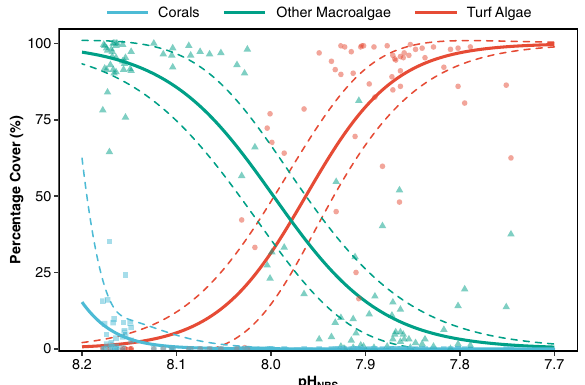
Fig. 3 In fl uence of pH on the coverage of turf algae, other macroalgae and corals. Mean cover (%) of turf algae (red circles), other macroalgae (green triangles) and corals (blue squares) along a seawater pH NBS gradient off Shikine Island, Japan. Solid lines represent a negative binomial generalised linear model (df = 99 biologically independent samples), with the dashed lines representing the 95% con fi dence interval. The pseudo- R 2 value of the three models are: turf algae 0.748, other macroalgae 0.773, and corals